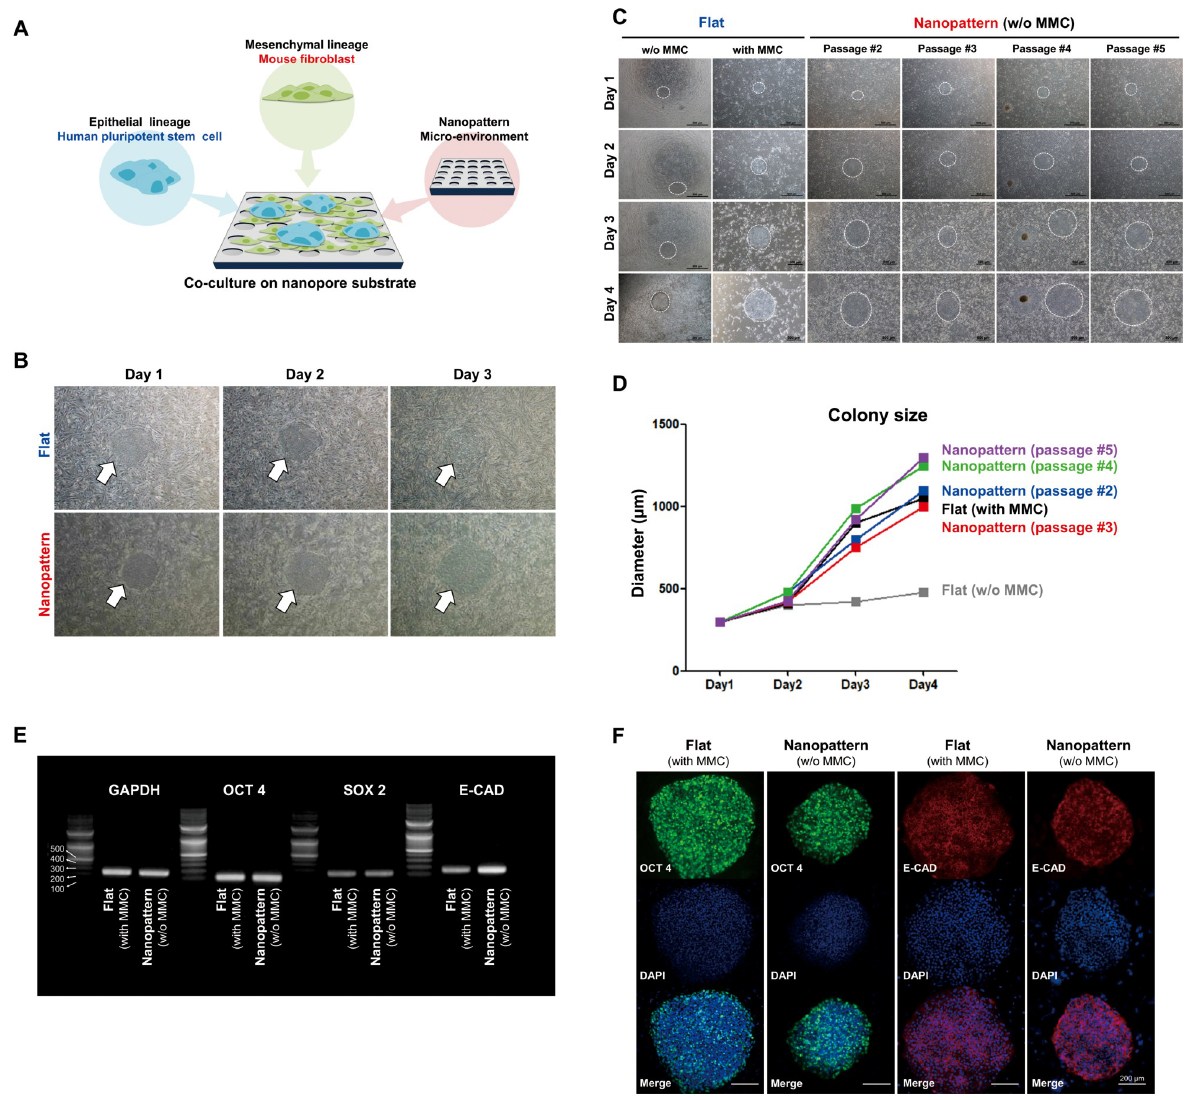
Fig 2. Analysis of co-culture potential of epithelial lineage cells and mesenchymal lineage cells using nanopatterns. (A) Schematic diagram of the development strategy for co-culture system using nanopatterned dishes. (B) Expansion of hPSCs co-cultured with proliferative mouse fibroblasts on flat and nanopattern using for 3 days. (C) Observation of growth capacity for hPSCs co-cultured with proliferative fibroblast and MMC-treated fibroblast on flat and nanopattern throughout multiple passages. (D) Diametric quantification of colony size for Fig 2C. (E and F) Comparison of the pluripotent specific genes (E) and proteins (F) expression between hPSCs co-cultured with MMC-treated fibroblast cells on flat and hPSCs co-cultured with proliferative (without MMC treatment) fibroblast cells on nanopatterned dishes.